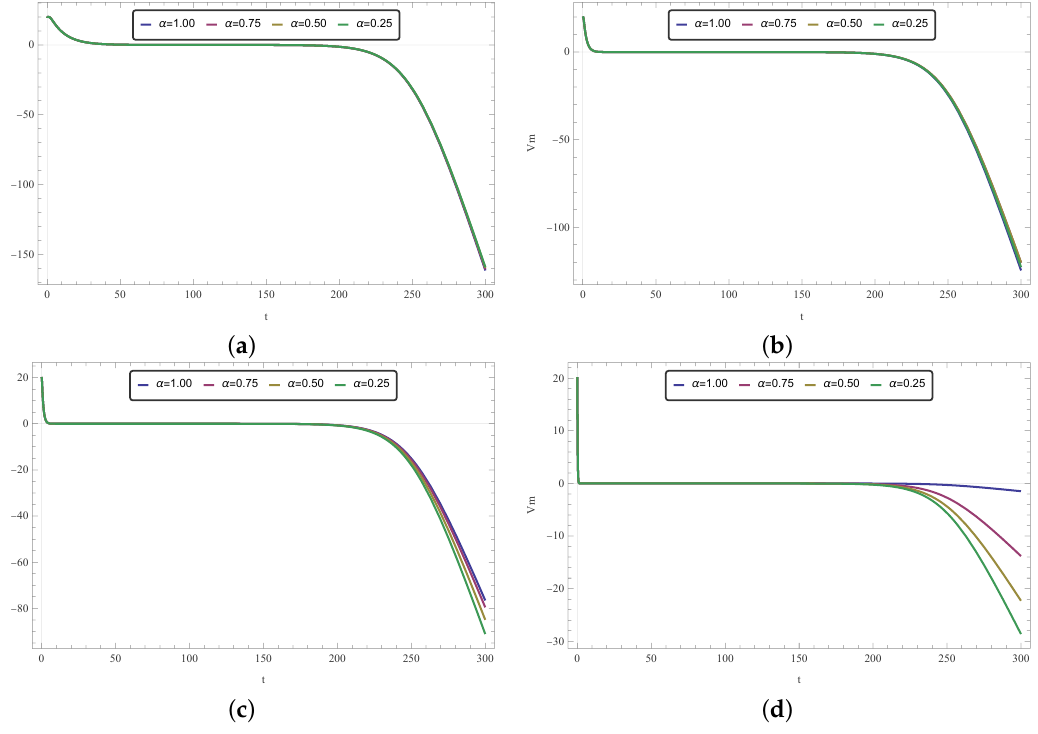
Figure 12. Time plots for Equation (18) with x = 0.5. Exploratory comparison between different values of α and k . ( a ) k = 1 × 10 − 2 mm 2 /ms, ( b ) k = 5 × 10 − 2 mm 2 /ms, ( c ) k = 1 × 10 − 1 mm 2 /ms, ( d ) k = 5 × 10 − 1 mm 2 /ms.